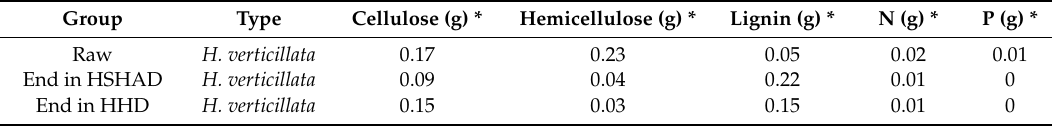
Table 2. Changes of the main composition at the end of the experiment (per g H. verticillate